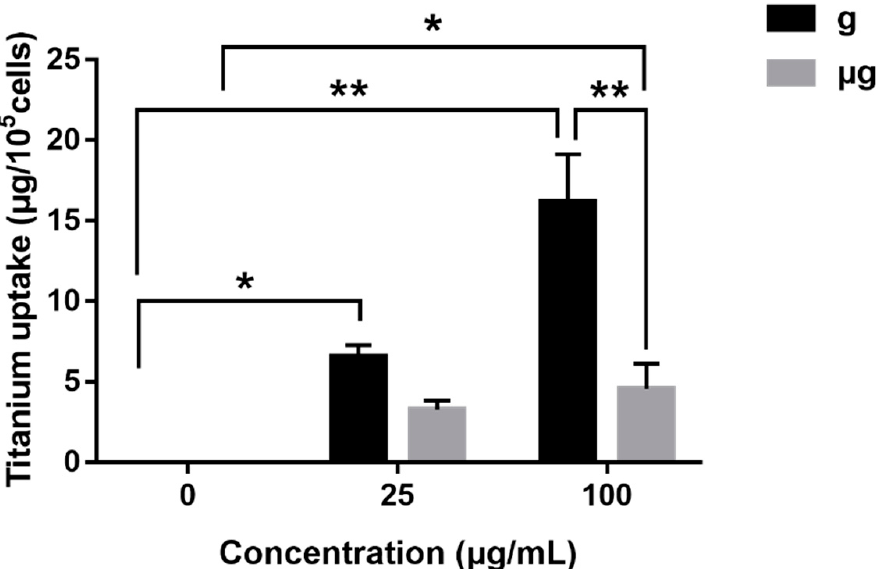
Figure 10. Cellular uptake of TiO 2 NPs by A549 cells. A549 cells were treated with TiO 2 NPs (0, 25 and 100 µ g/mL) for 48 h under normal gravity (g group) and simulated microgravity ( µ g group). Ti content was determined by ICP-OES. A calibration curve was constructed using standard titanium dilutions of a reference solution and the correlation coefficient (R 2 ) was 0.99996. All values were presented as mean ± SD ( n = 3). * p < 0.05, ** p <